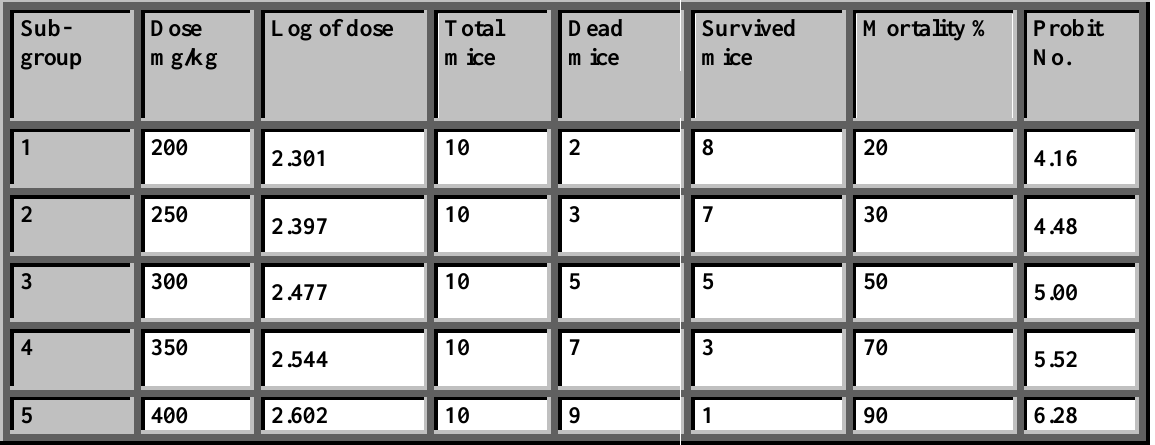
Table 3:- Acute toxicity effect of different doses of hexane extract of PFG of N.oleander leaves in mice.